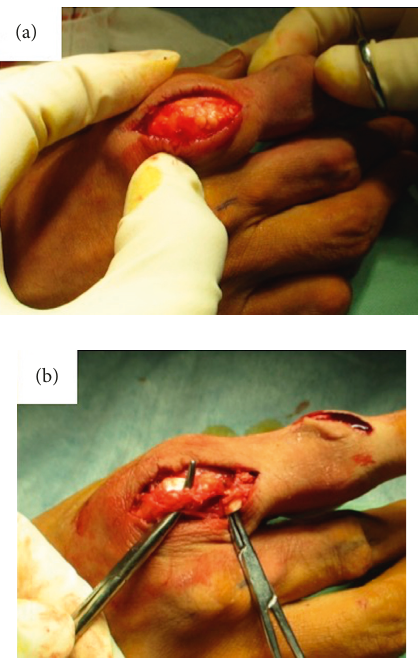
Figure 3: (a) Intraoperative findings. Hypertrophic white crystal deposits consistent with gouty tophi are seen surrounding the extensor digitorum communis of the index finger and extensor indicis proprius tendon. (b) After debridement of the tophi, the extensor indicis proprius was found to be intact but slightly elongated.